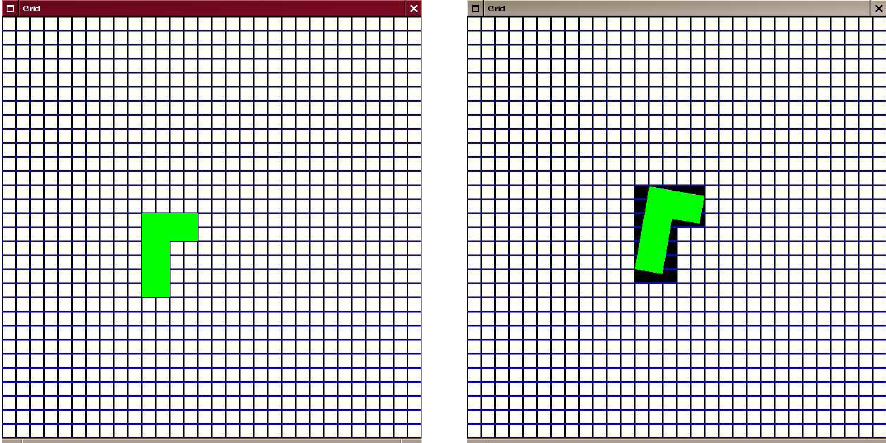
Figure 5. Aliasing problem: the area of an object counted in occupied cell number is not constant for each position of the object in the grid. Reproduced with permission from reference [30]. Copytight 2006